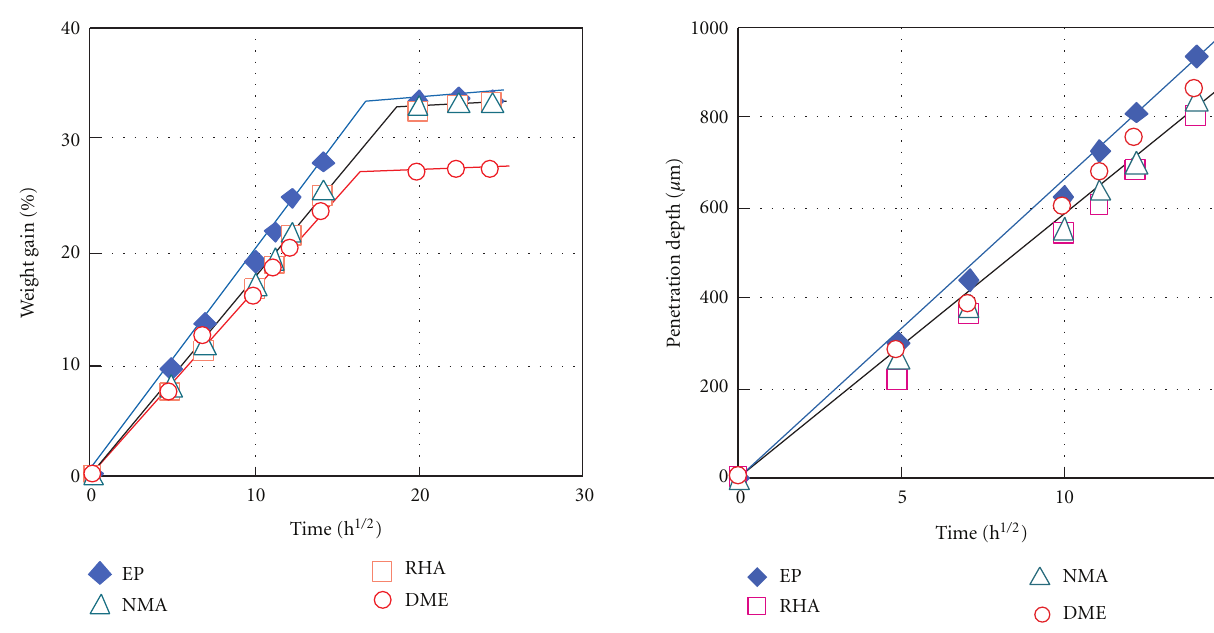
Figure 7: Weight change of neat epoxy (EP), normal mixing (NMA), shear mixing (RHA), and high-speed mixing (DME) nanocomposite in terms of square root of time in 10% of sulfuric acid solution at 60 ◦ C.